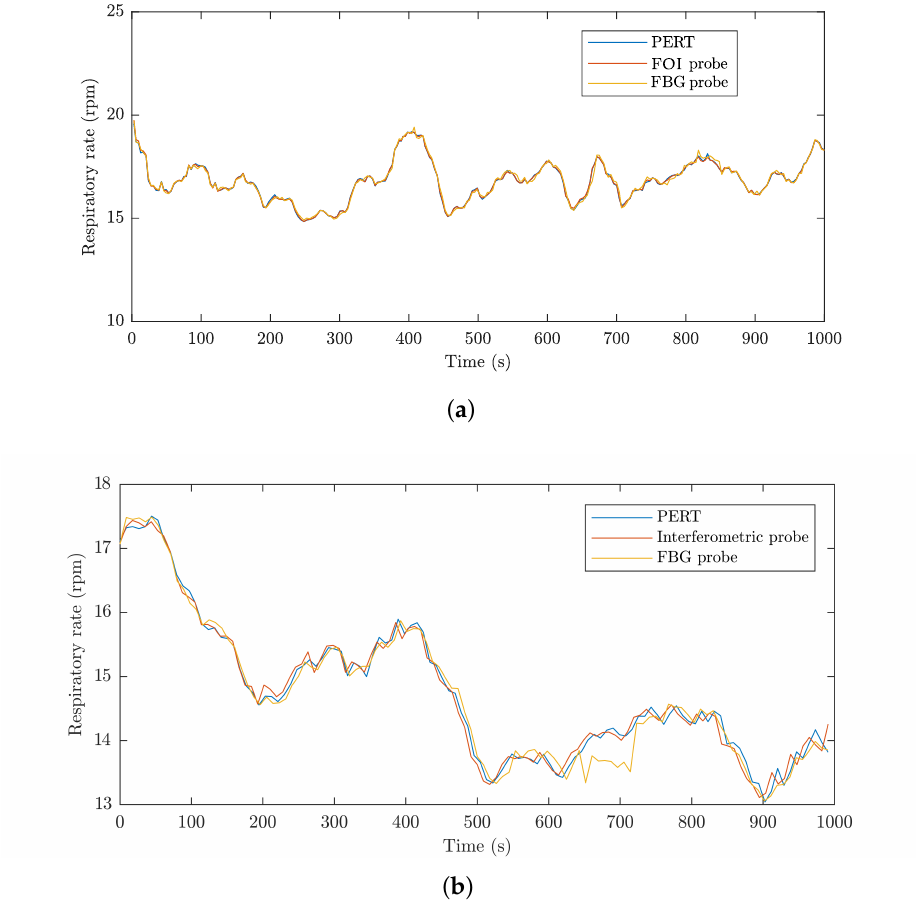
Figure 12. ( a ) an example of the RR waveform for subject M1; ( b ) an example of the RR waveform for subject